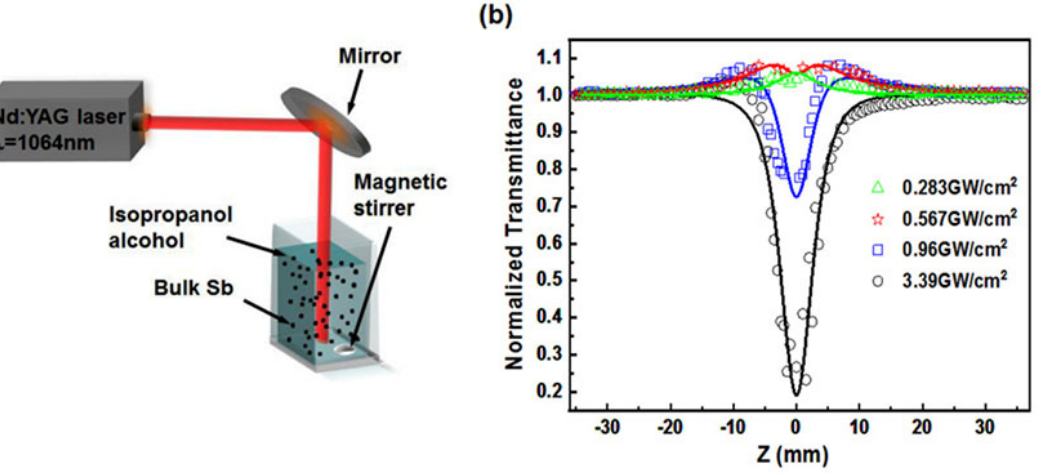
Figure 11. ( a ) Schematic diagram of laser irradiation; ( b ) The results of the open–hole Z–scan experiment. Reprinted with permission from Ref. [25]. Copyright 2020, American Institute of Physics.